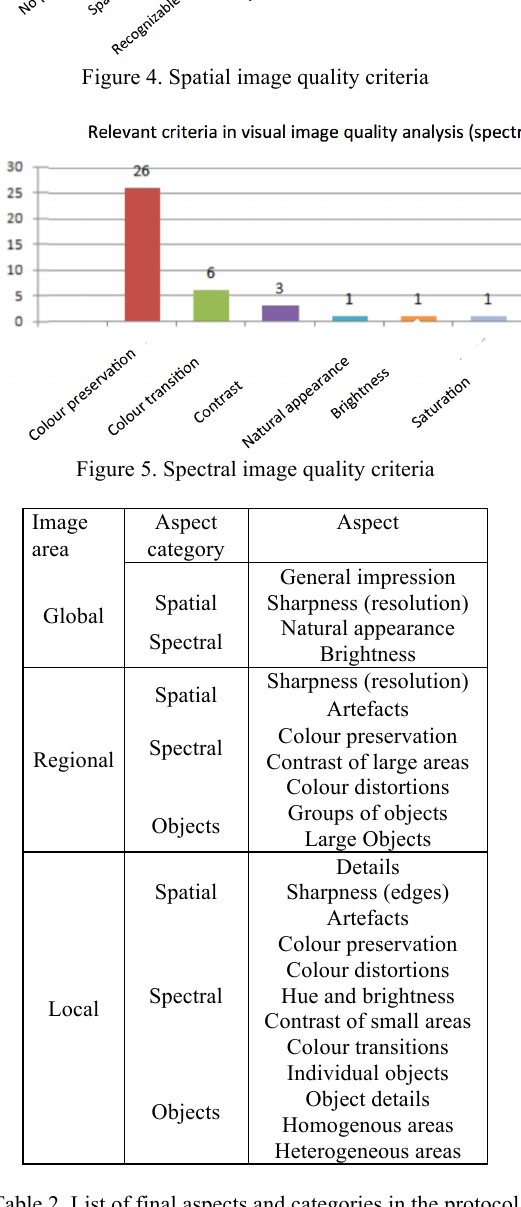
Table 2. List of final aspects and categories in the